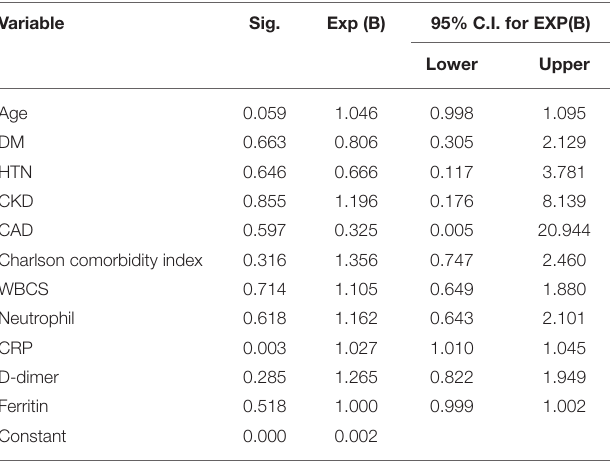
TABLE 3 | Logistic regression analysis for independent predictors of ICU admission.